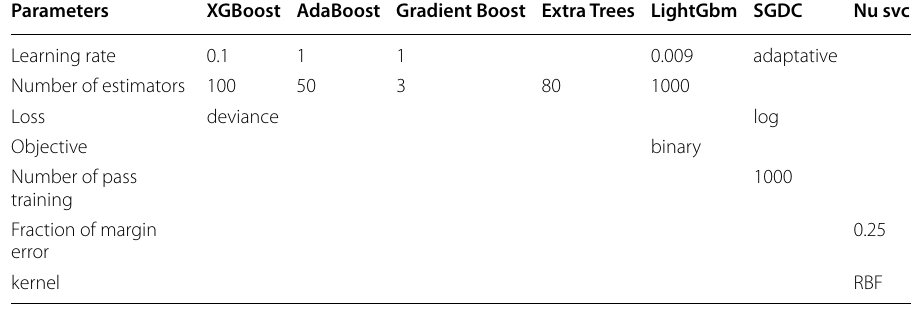
Table 3 Algorithm parameters